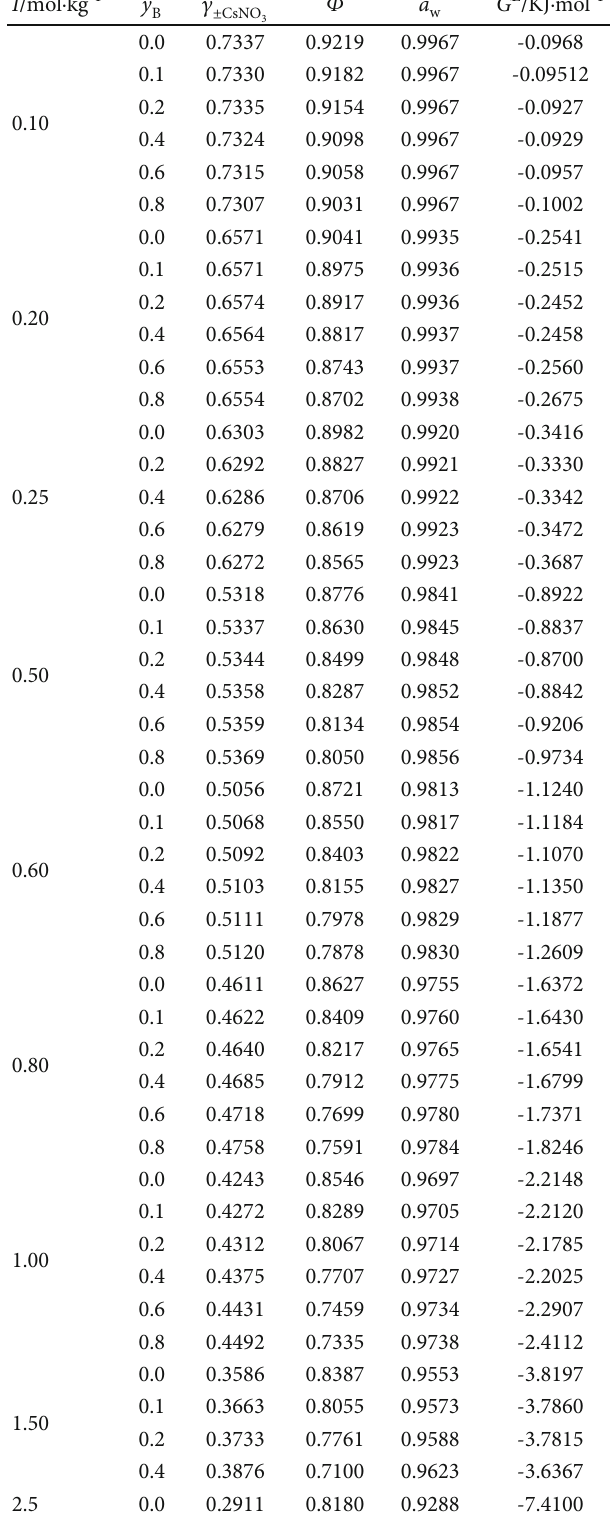
Table 7: The mean activity coe ffi cients of CsNO coe ffi cients, water activities, and excess free energies in the ternary system a